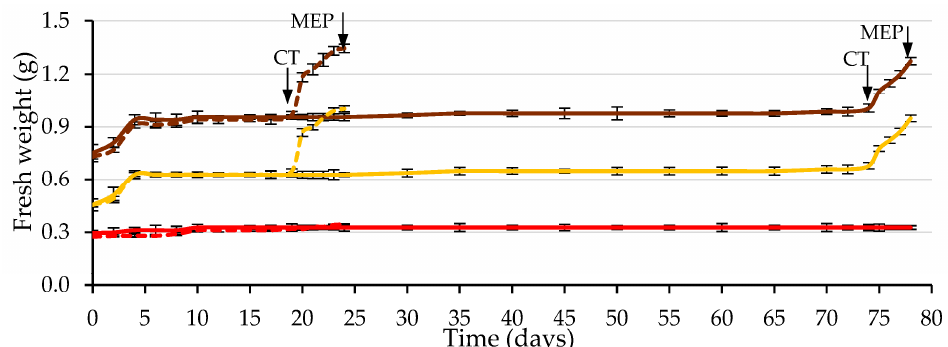
Figure 8. Time course of fresh weight (water uptake) during the germination test of caper seeds, considering seeds with testa (brown), the testa (red) and the endosperm containing the embryo (yellow). Seeds wetted with water are shown as solid lines, and those wetted with the 500 mg L − 1 GA 3 solution are shown as dashed lines (up to Day 19, solid and dashed lines practically overlap). The arrows indicate the dates on which the cracking of the testa (CT) and the piercing of the micropylar endosperm (MEP) occurred. Average values of four replicates of 10 seeds each. Vertical bars represent the standard error.